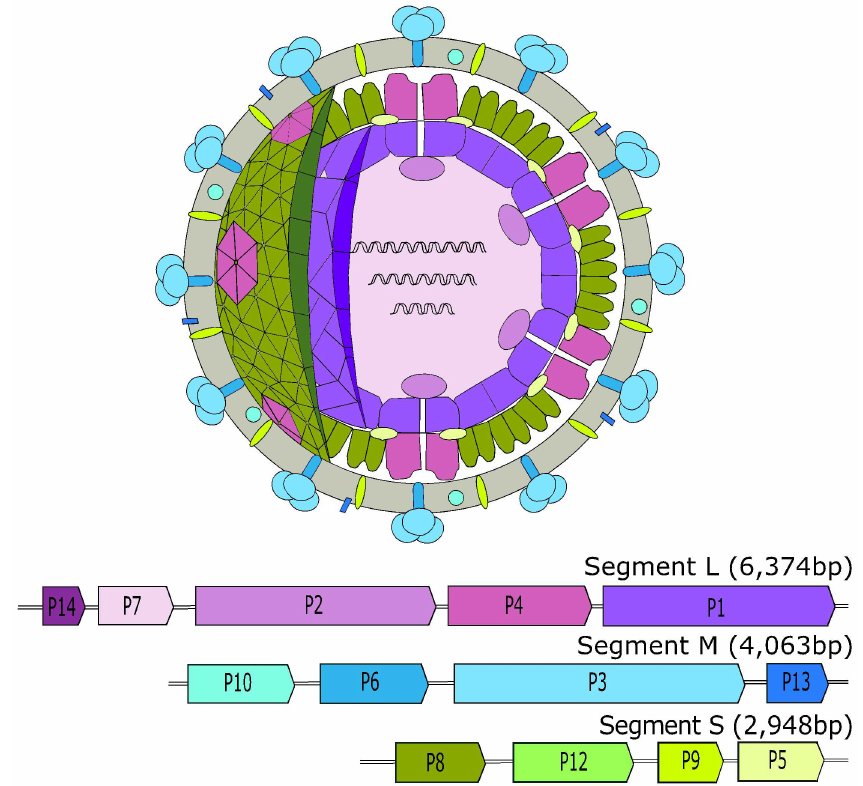
Figure 1. Virion of Pseudomonas phage phi6, the type virus of the Cystoviridae family. The virion and genes encoded by the tri-segmented genome of this phage are color co-ordinated. The grey circle represents the membrane encapsulating the virion. See text regarding gene information. (This figure was reproduced based on other images